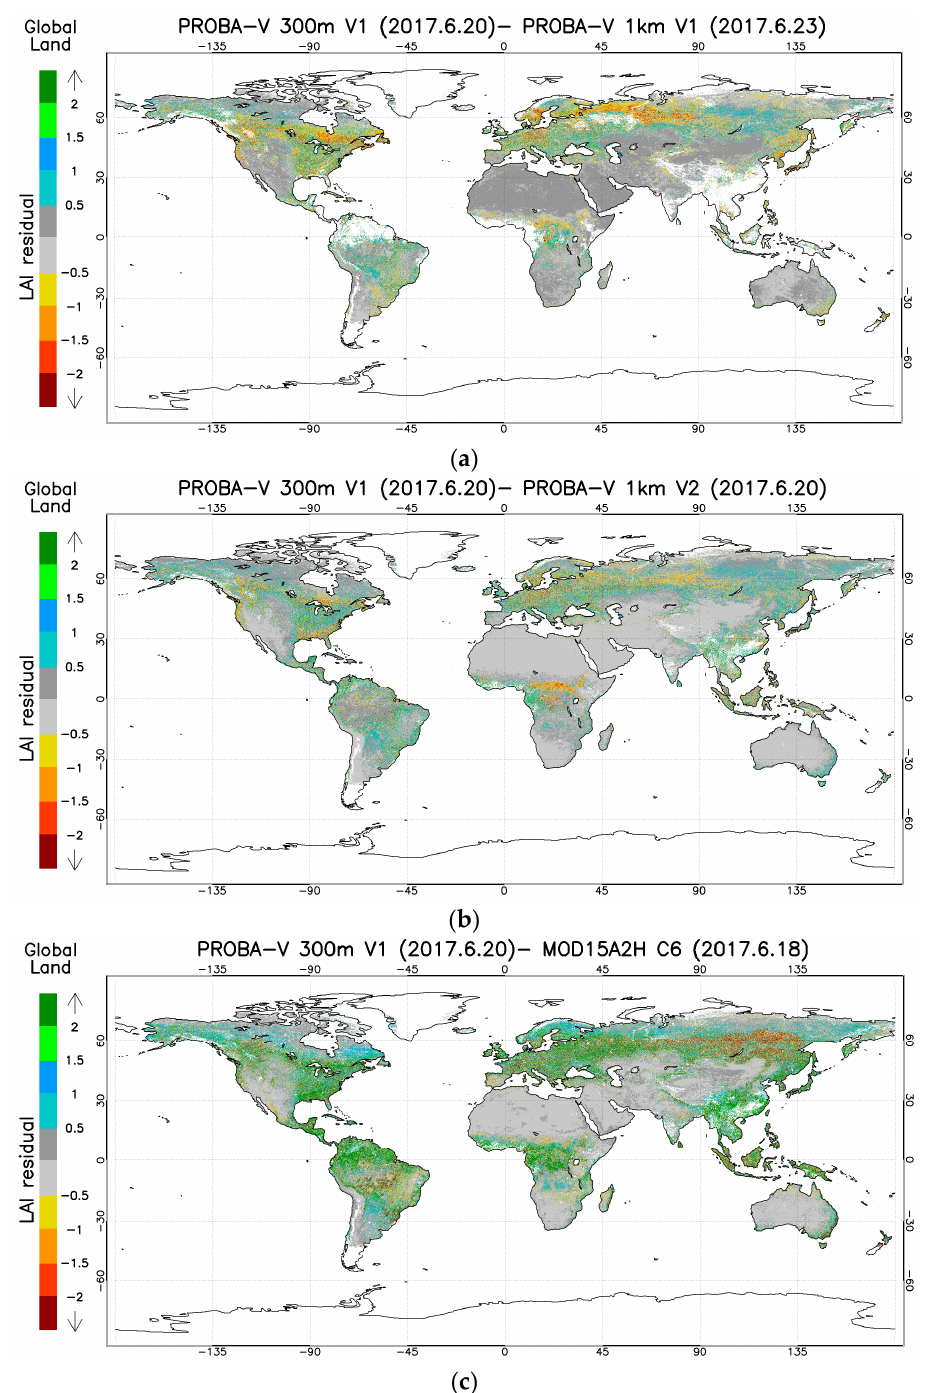
Figure 2. LAI residual map between PROBA ‐ V Collection 300 m V1 and Collection 1 km V1 ( a ), Collection 1 km V2 ( b ), and MODIS C6 ( c ) for 20th June 2017.